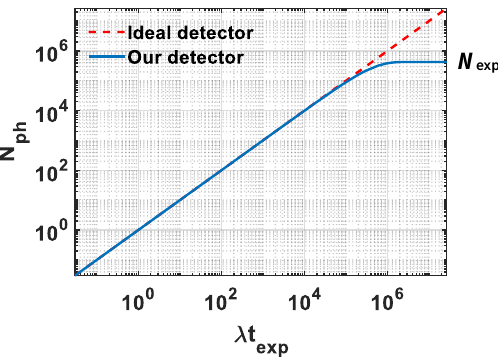
Figure 2. Modeling the photon count loss due to the detection of one count per observation window ( t exp = 30-ms).